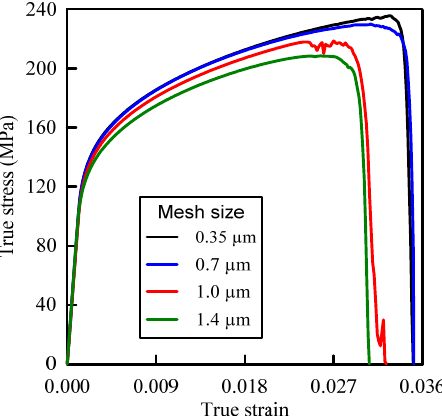
Figure 2. Tensile true stress–strain curves for A359/SiC composite using different FE mesh sizes (PS = 10 µm, 10% volume fraction (VF)). Table 1. Mesh size effect on the failure strain and ultimate tensile strength. Mesh Size (µm) Element Number Failure Strain Ultimate Tensile Strength (MPa)